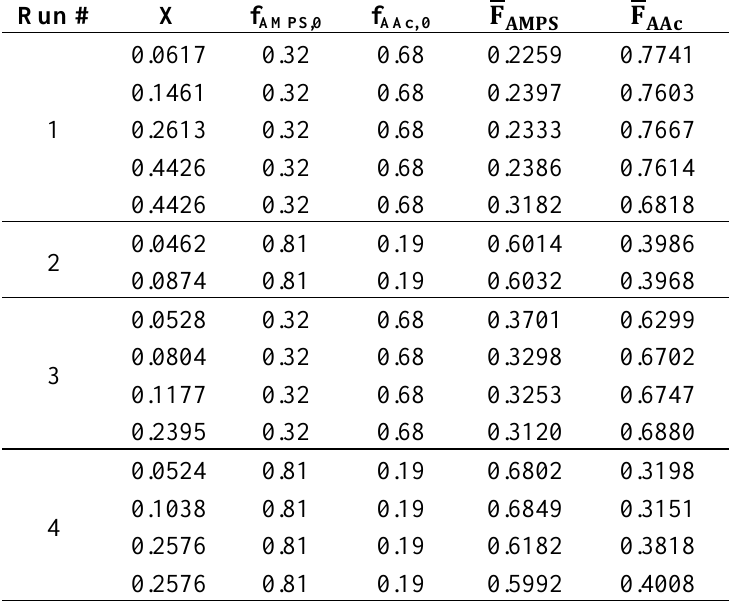
Table A3. Experimental data for AMPS/AAc copolymerization; Tidwell-Mortimer design.